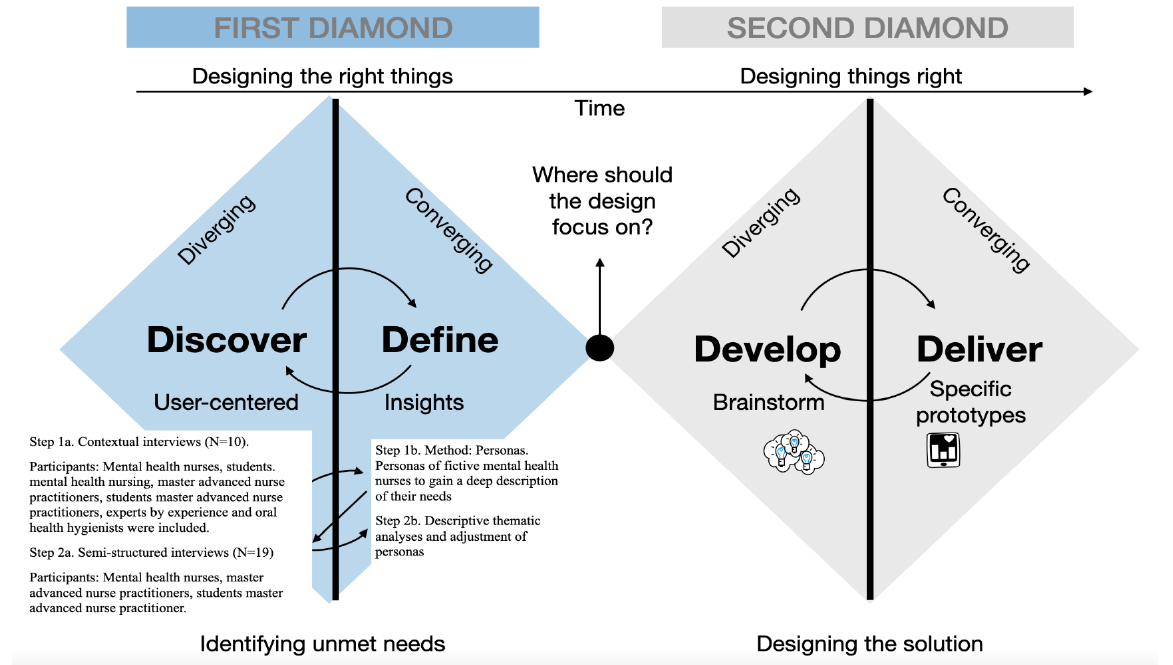
Figure 1. The iterative HCD stages and activities used in the first diamond of the Double Diamond model from the Design Council [28], adapted with permission from van ’t Veer, Wouters, Veeger, van der Lugt, 2021 [34]. Copyright 2020 by publisher Coutinho, Bussum, the Netherlands. Note: HCD (human centered design) stages and activities in the two diamonds of the Double Diamond model [28]. Steps 1a – 2b describe each stage of our project (discover and define). As HCD is an iterative process, the arrows describe how the results of each step impact the next step, leading to a detailed description of four different personas regarding oral health and adjustment of the personas in the last step (step 2b).